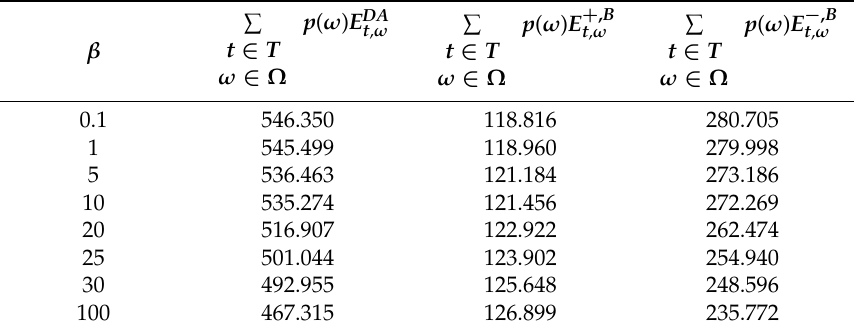
Figure 9. Expected profit versus profit standard deviation for different levels of β . Table 1. Total expected energy (MWh) traded by the aggregator in DA and balancing markets.